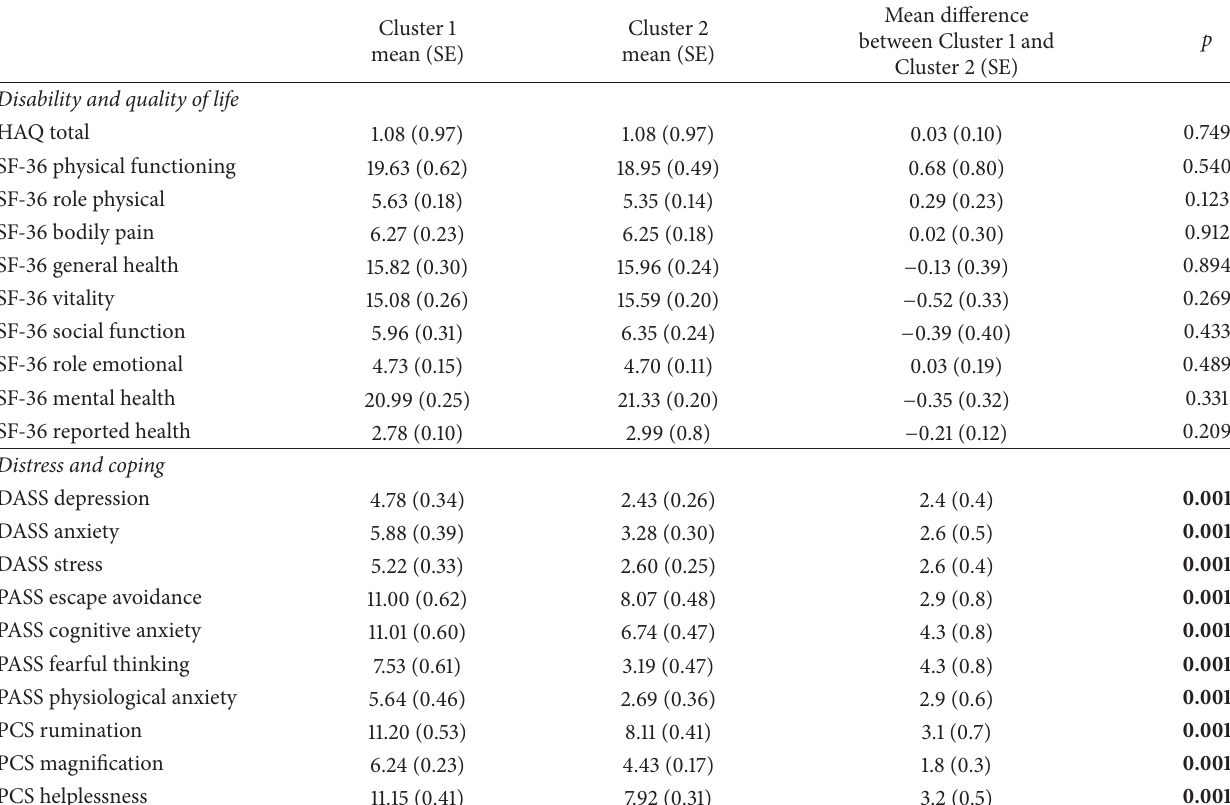
Table 2: MANCOVA adjusted for years since RA diagnosis between clusters